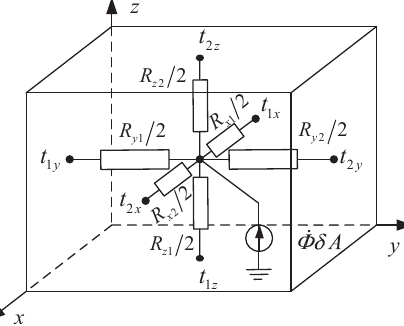
Figure 10. Basic 3-D elements of the thermal network of the heat source.